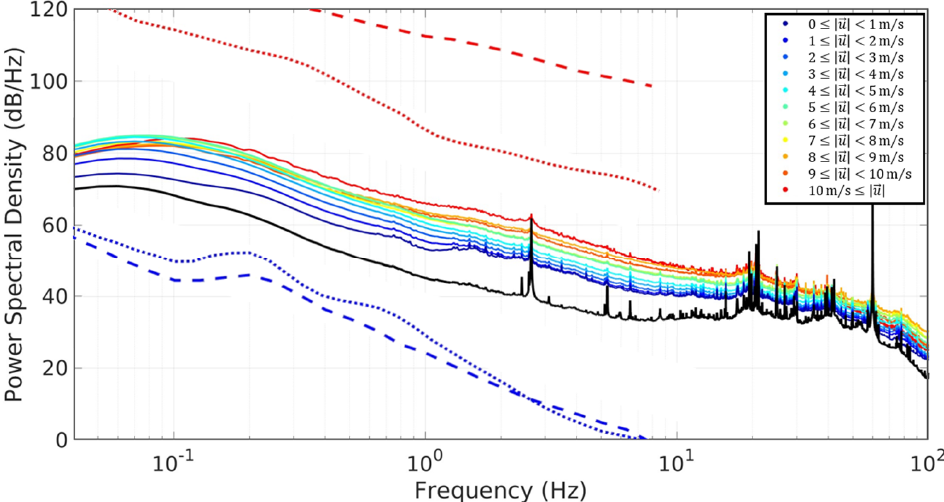
Figure 6. Mean spectra binned based on the average wind speeds measured by a nearby Mesonet site. The global low and high noise models [34,35] are included for reference. The thick black curve is the average of times when a recurring local noise source was present.